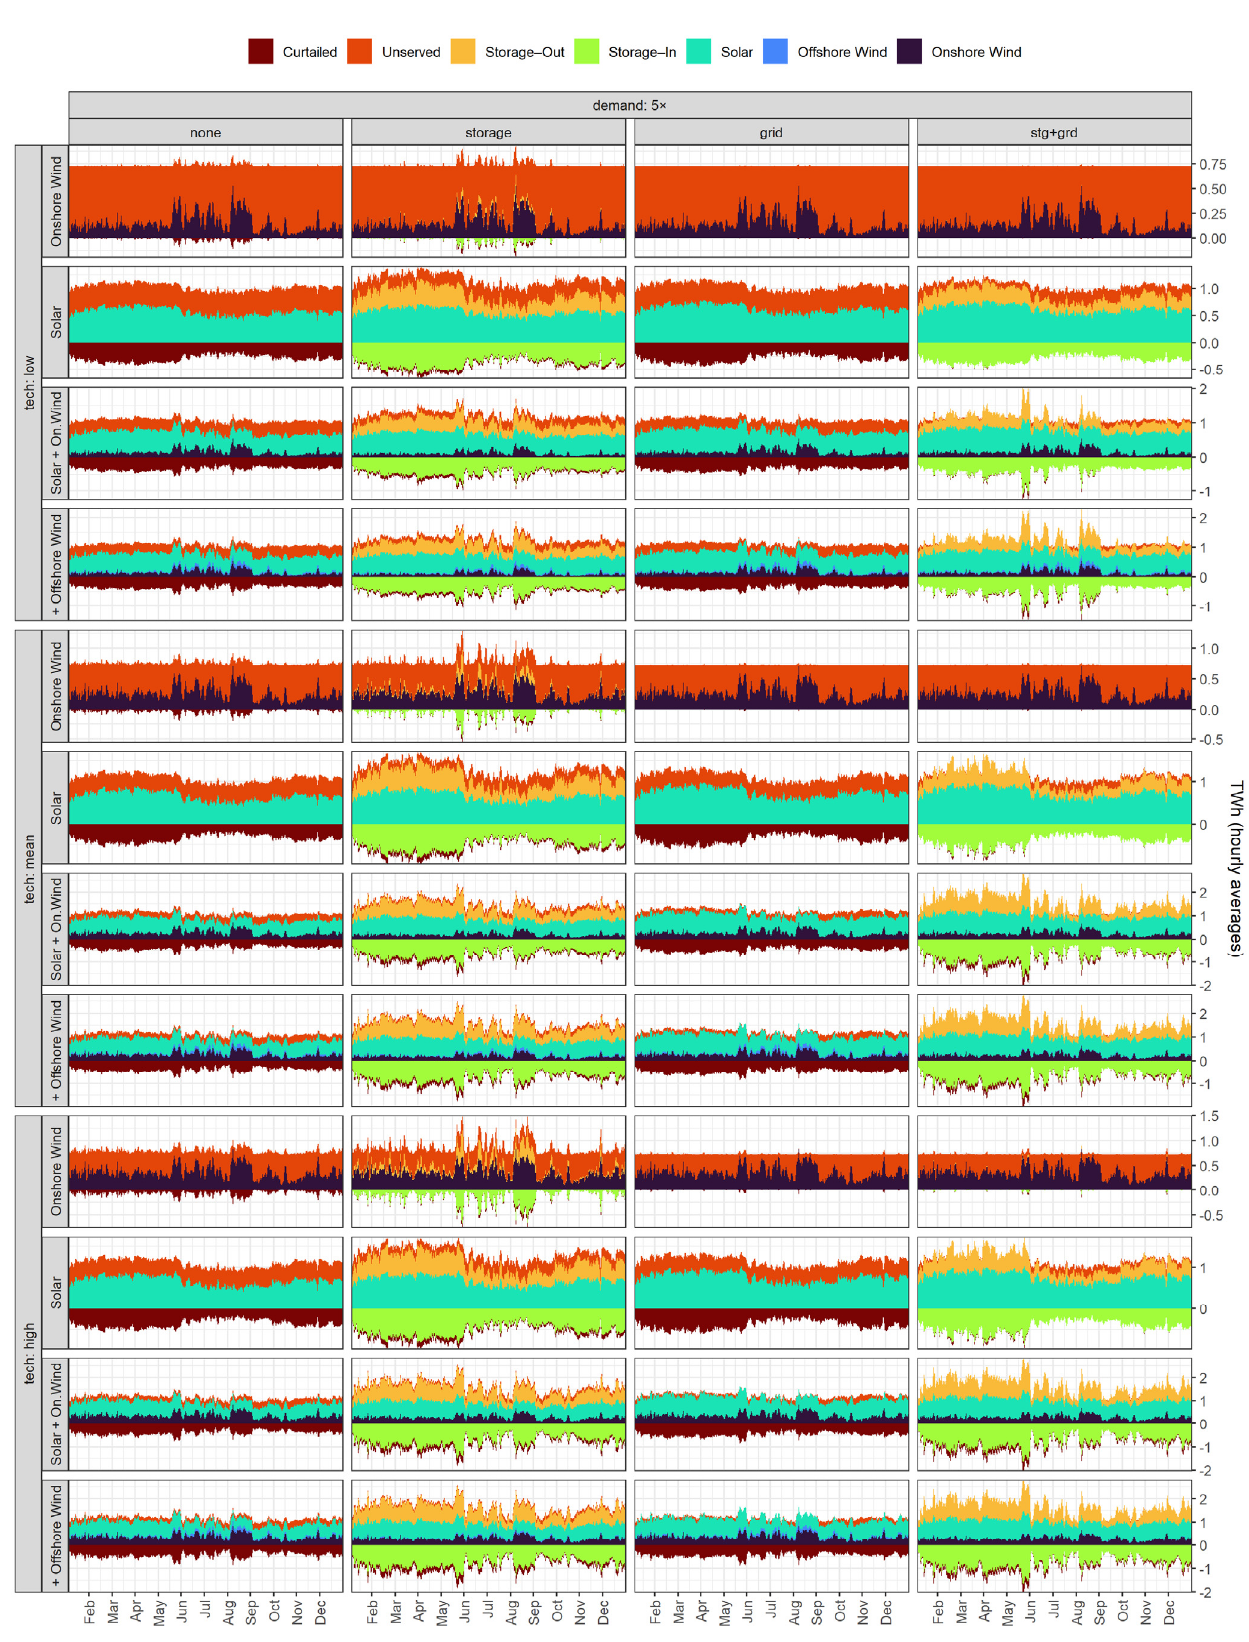
Figure A22. Annual operation profile by scenario (5× group), national aggregation, 2020 weather year.